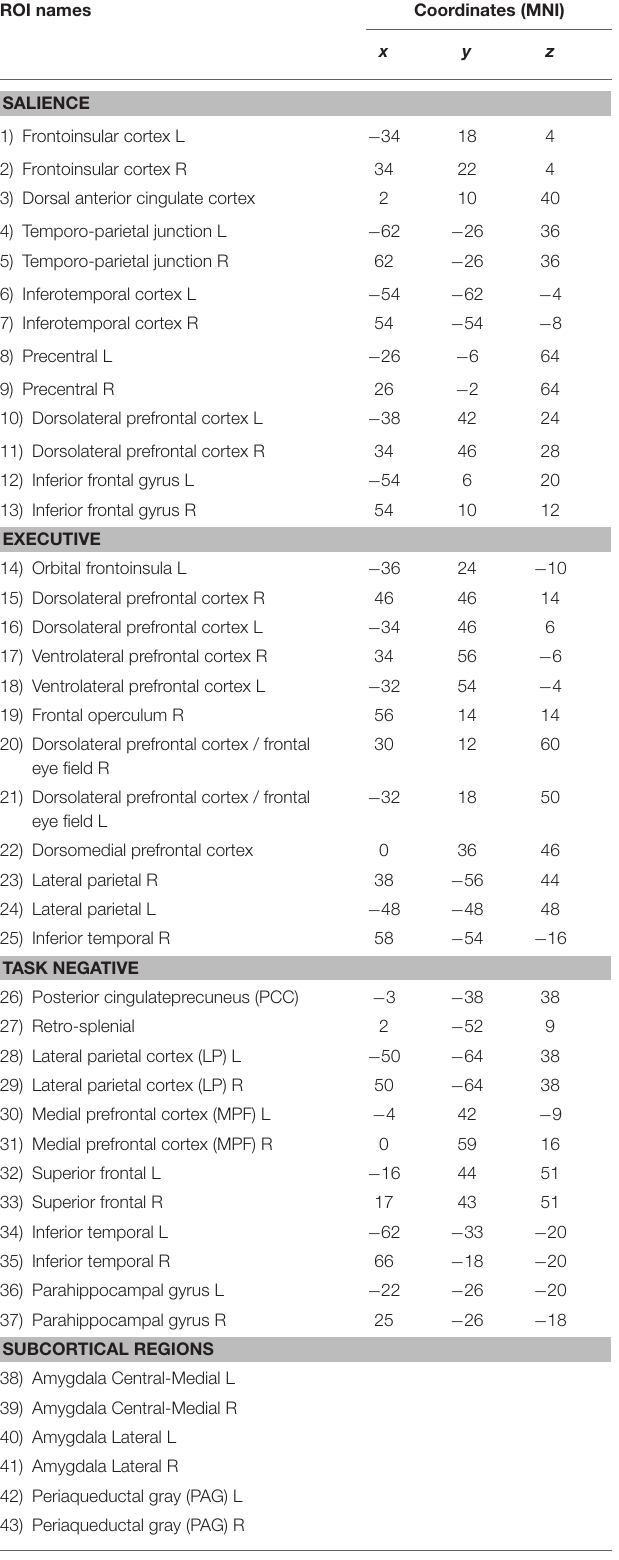
TABLE 1 | List of cortical and subcortical Regions of Interest (ROIs). ROI